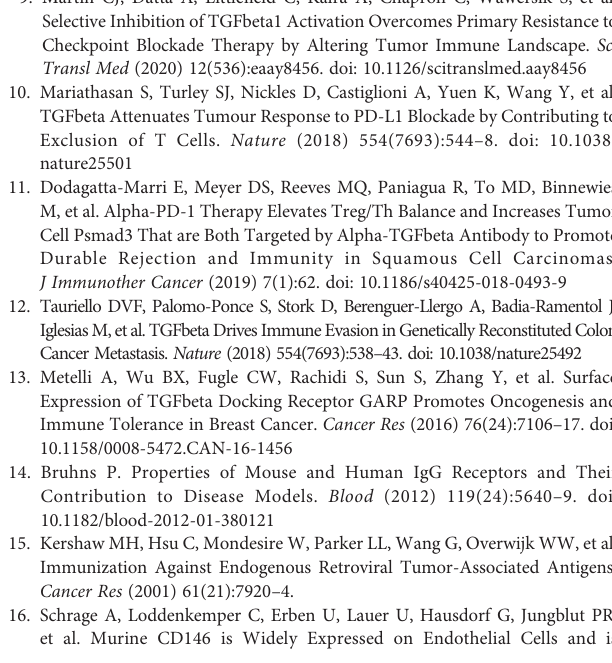
the indicated groups. One tumor section analyzed per mouse. Supplementary Figure6 | C166andMS1endothelialcellsdonotactivateTGF- b 1 in vitro in absence of stimulus or another cell type. C166 and MS1 cells were used to perform a proliferation assay as described in Figure 5B . Incorporation of 3 H-T was measured after 96 hours of culture in the presence of blocking anti-GARP:TGF- b 1 (clone 58A2) or neutralizing anti-TGF- b 1, b 2, b 3 (clone 1D11) mAbs. Bars indicate means (+ SD) for triplicate wells. Data representative of 3 independent experiments. Supplementary Figure 7 | Combined GARP:TGF- b 1/PD-1 blockade increases expression of Sell butnotof Icam1 and Vcam1 in MC38tumors. RT-qPCR analyses relative to Figure 6A . Graphs show the expression level of Icam1 , Vcam1 and Sell normalized by Actb , Cd3e or Cd146 . Data points represent values measured in individual mice. Horizontal bars: median per group. Number in italics indicate P values < 0.05 as calculated with a two-sided Wilcoxon test, and numbers in bold indicate fold-changes between groups for selected comparisons. Supplementary Table 1 | Primers and probes